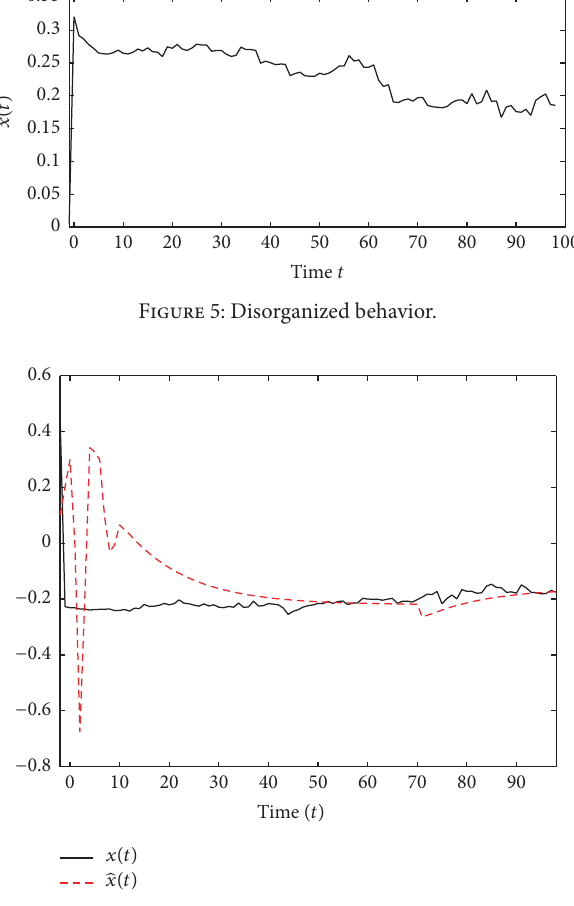
Figure 3: Evolutive behavior of 𝑥 2 (𝑡) and ̂𝑥 2 (𝑡) .